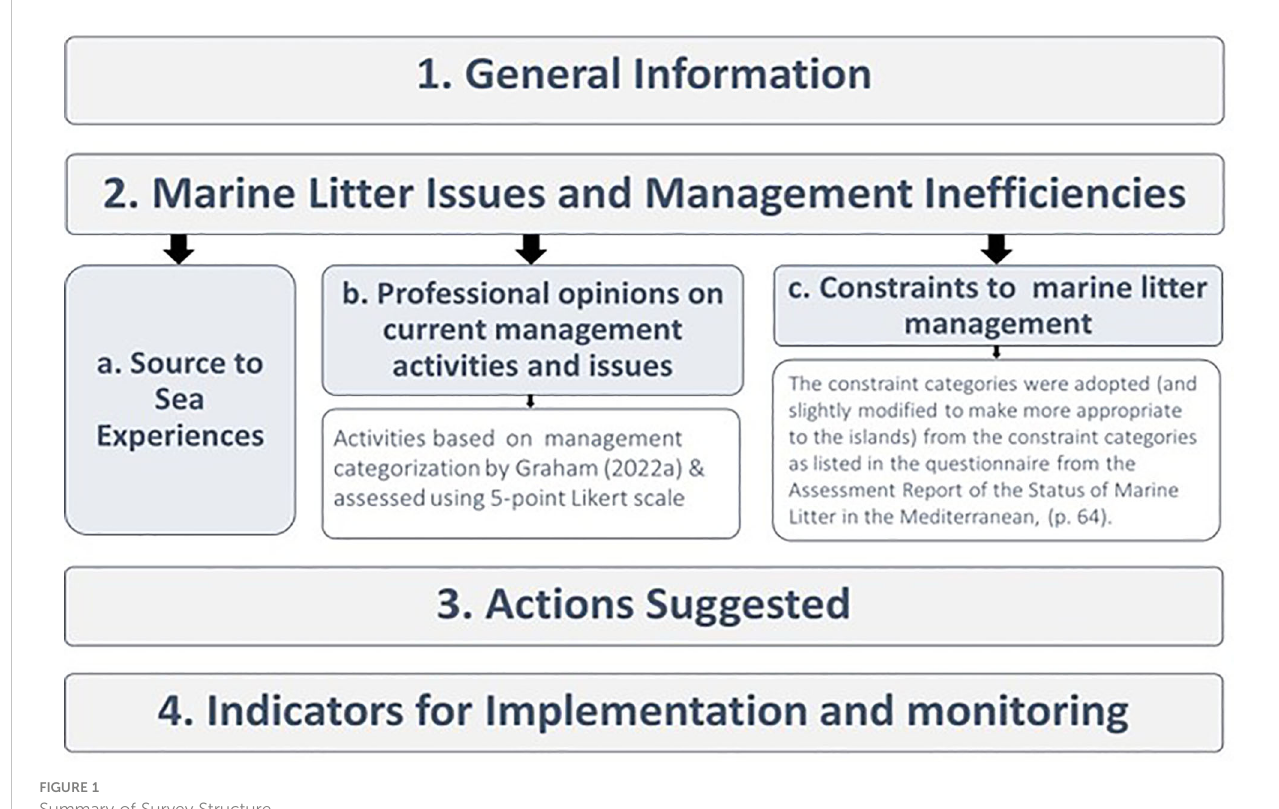
FIGURE 1 Summary of Survey